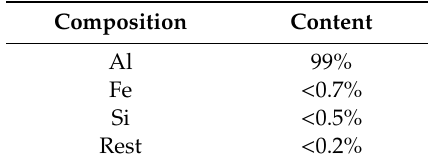
Table 2. Chemical composition of aluminum foil.